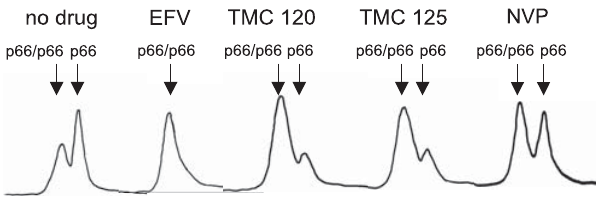
Figure 1. NNRTI Enhancement of p66 Homodimer Formation In